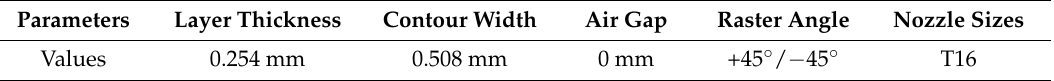
Table 1. Process parameters for the additive manufacturing (AM)